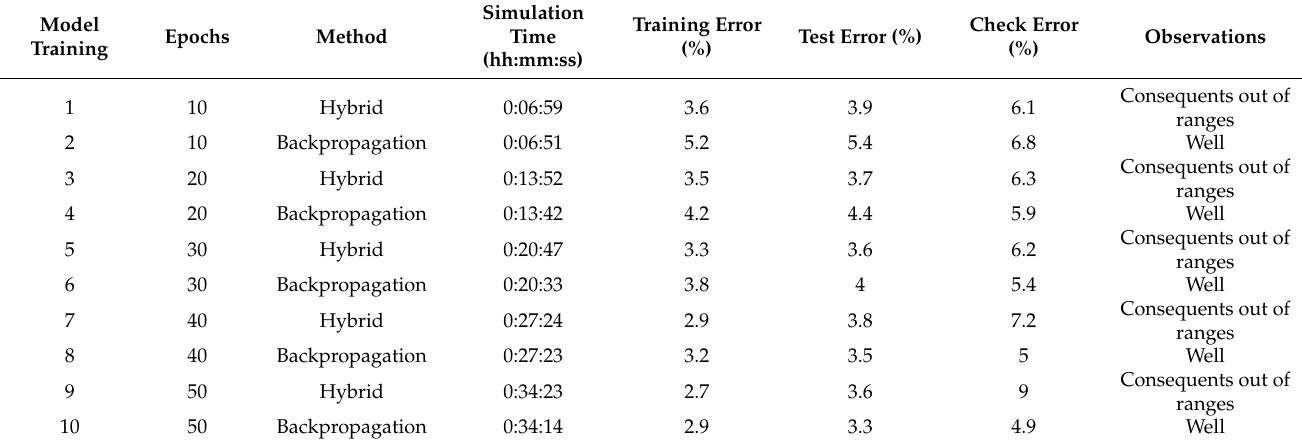
Table 3. The best training phase for obtaining the final Adaptive-Network-based Fuzzy Inference System (ANFIS) model. Model